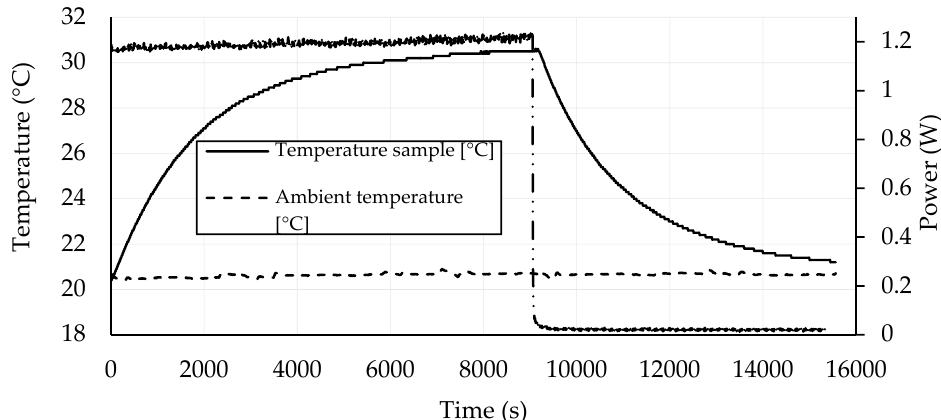
Figure 11. Self-heating experiment—CB 2, 40 V.